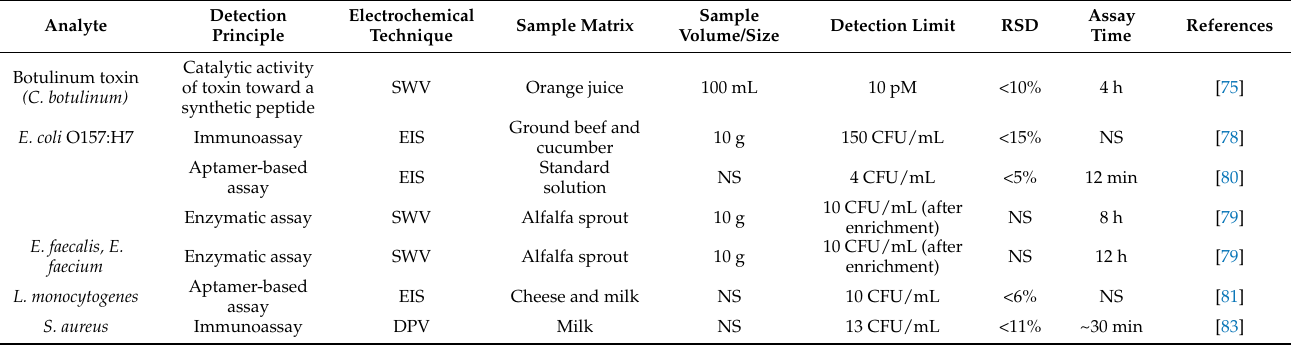
Table 3. Detection of foodborne pathogens in